Question: What style of plot is this figure drawn as?
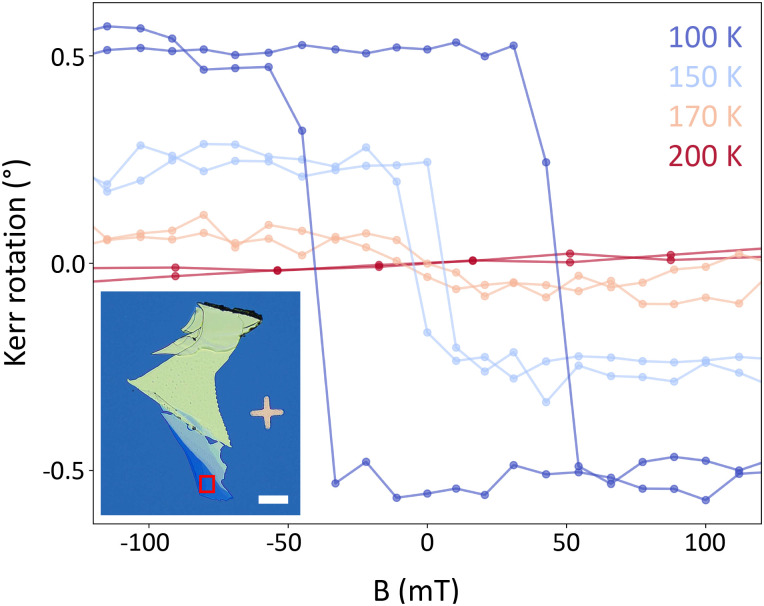
Answer: line